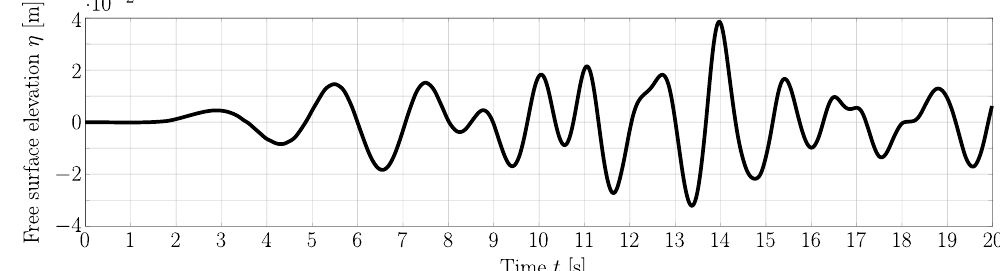
Figure 4. Time trace of the incident, irregular wave train measured in the CFD-based NWT at the intended WEC